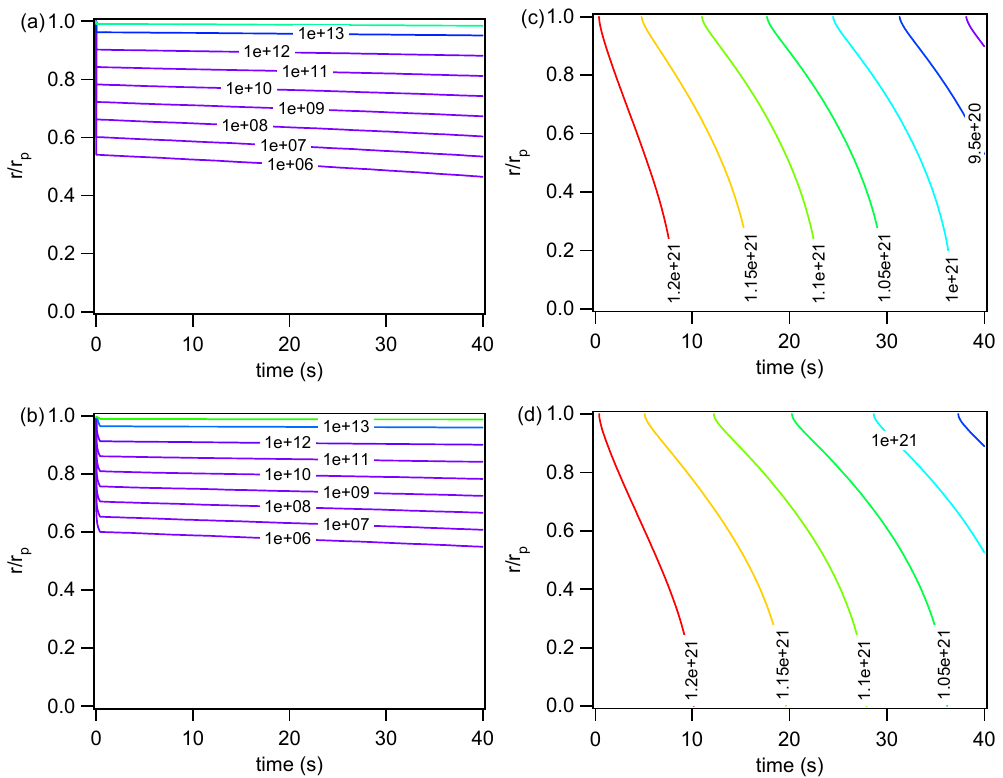
Fig. A1. Temporal evolution of bulk concentration profiles for ozone by (a) KM-SUB and (b) PDE method and for oleic acid by (c) KM-SUB Figure A1. 63 and (d) PDE method. The y-axis indicates the radial distance from the particle center ( r) normalized by the particle radius, ranging from the particle core ( r/r p ≈ 0) to the near-surface bulk ( r/r p = 1). The colored lines are isopleths of bulk concentration with labeled in units of cm − 3 (blue = low, red =